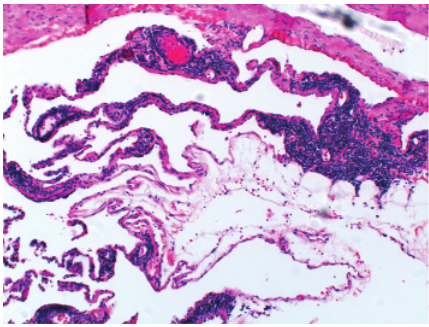
Figure 2: Configuration of the three ports that were utilized for the operative excision of the cyst.